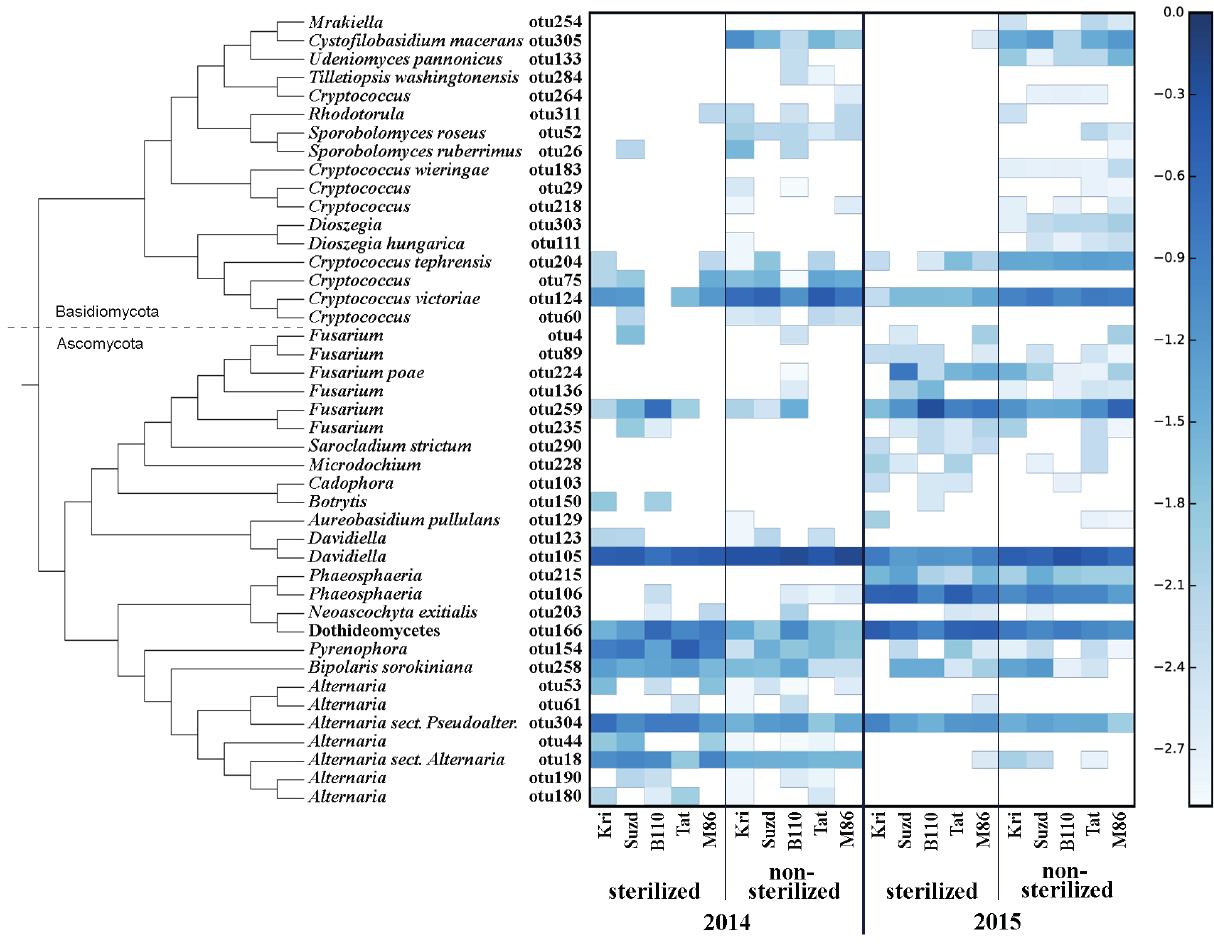
Figure 1 Maximum likelihood consensus tree and fungal taxa heat map of sterilized and non-sterilized grain samples, which were harvested in 2014 and 2015 years. Read counts of each OTU were weighted according to sum of reads in the sample and log-transformed. White corresponds to low and blue to high number of reads Kri –